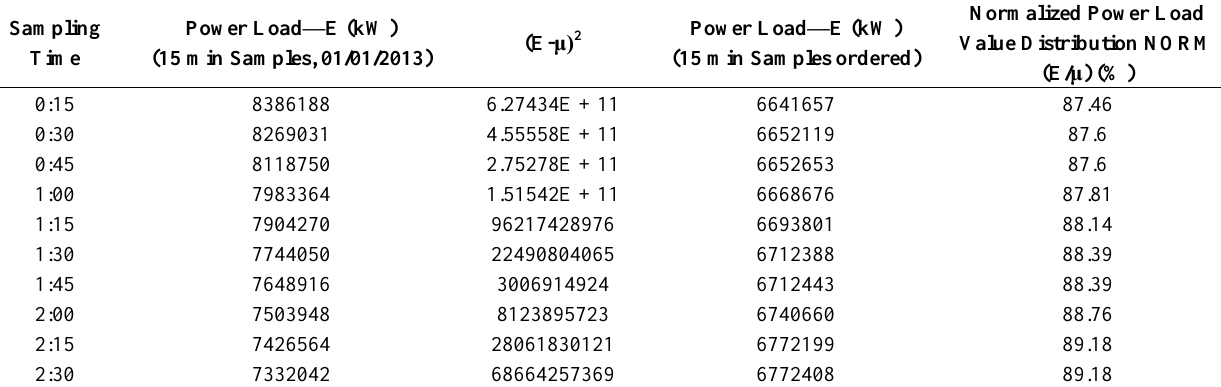
Table 2. Verification of electric values distribution model—source: Elia Bruxelles,